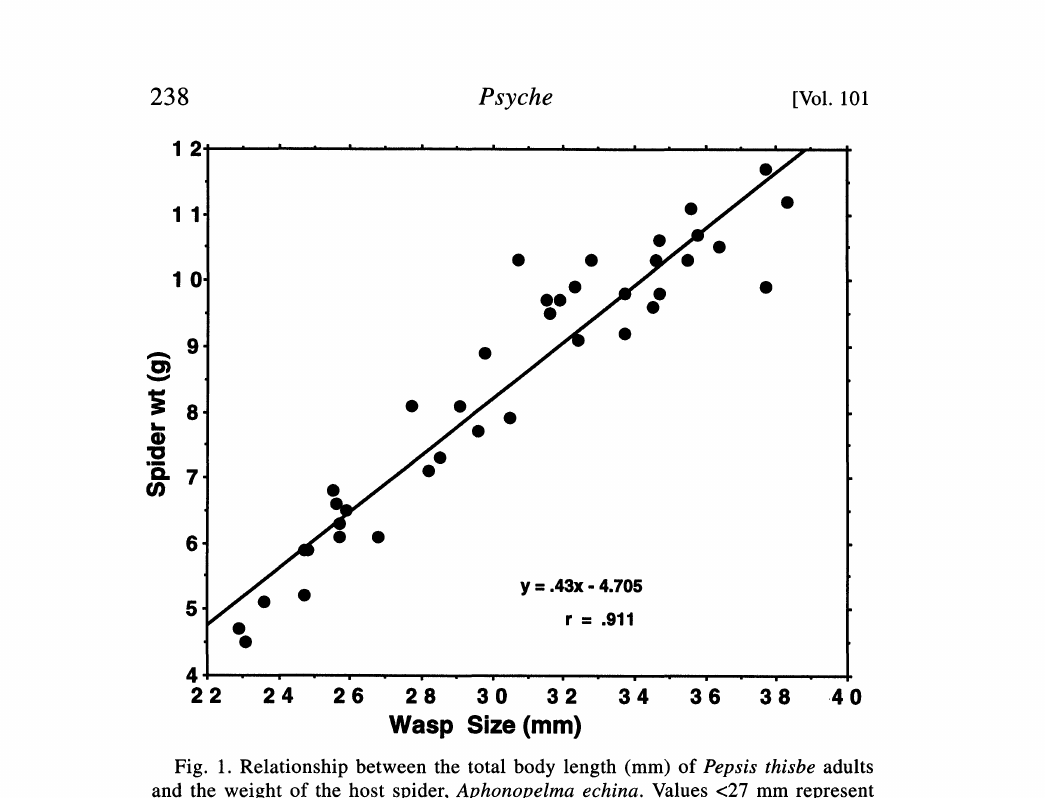
Fig. 1. Relationship between the total body length (mm) of Pepsis thisbe adults and the weight of the host spider, Aphonopelma echina. Values <27 mm represent males; >27 mm,